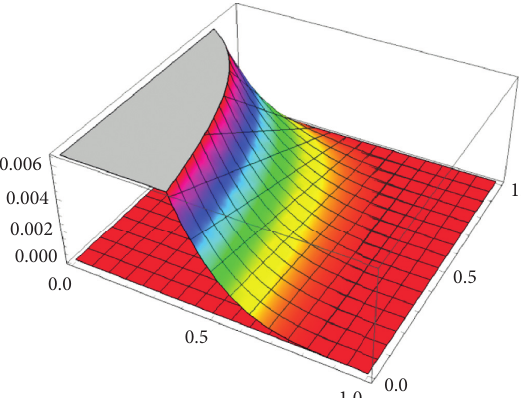
Figure 2: 0 is the common fixed point of H and K .